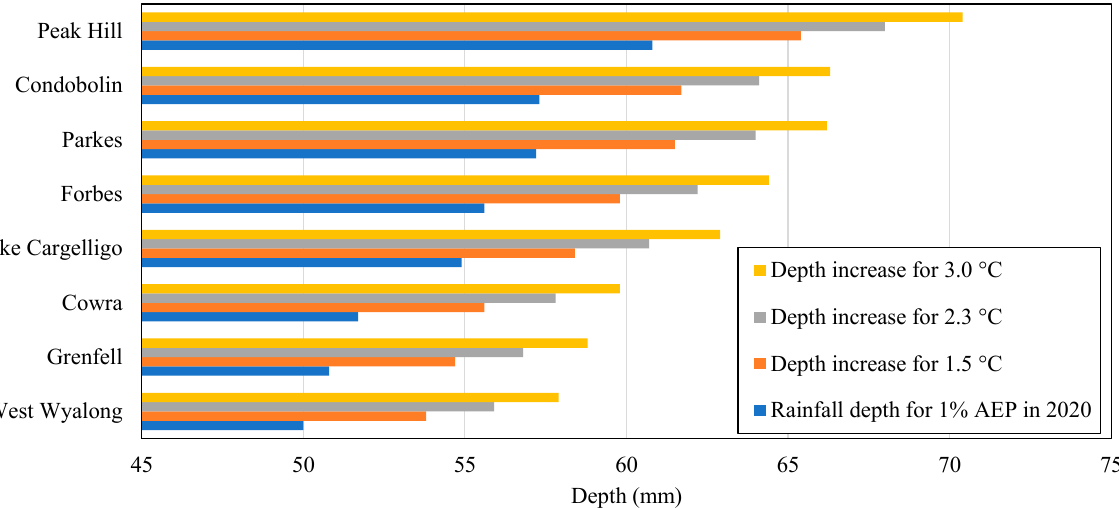
Figure 3. The 2070 projections compared with the current rainfall depth for a 60 min event of 1% AEP.